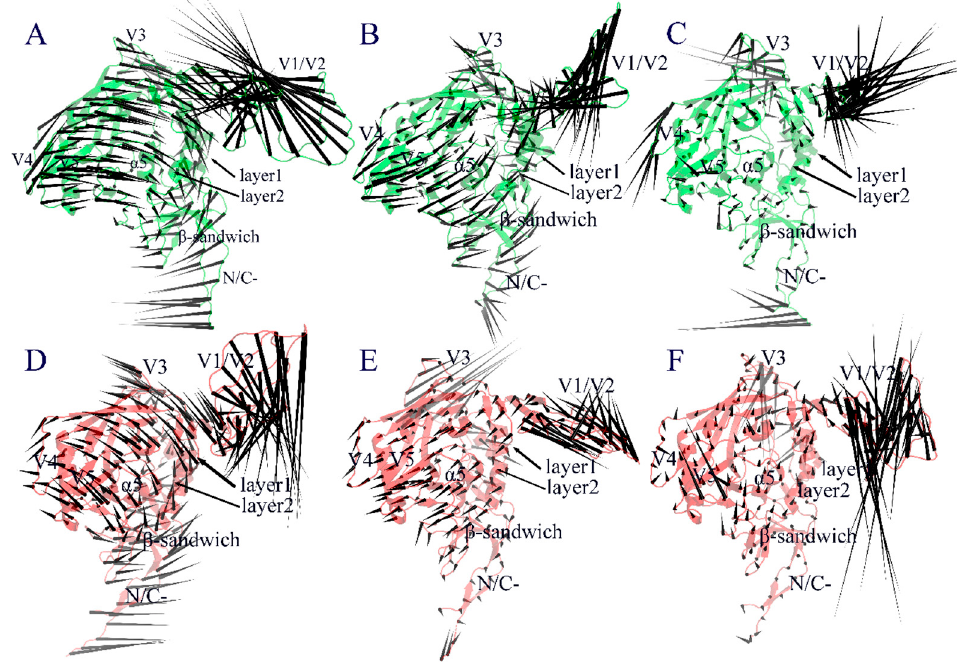
Figure 5. Porcupine plots showing the collective motions along the first three eigenvectors of gp120 the CD4-free ( A – C ) and CD4-complexed ( D – F ) in the CD4-free ( A – C ) and CD4-complexed ( D – F ) forms.